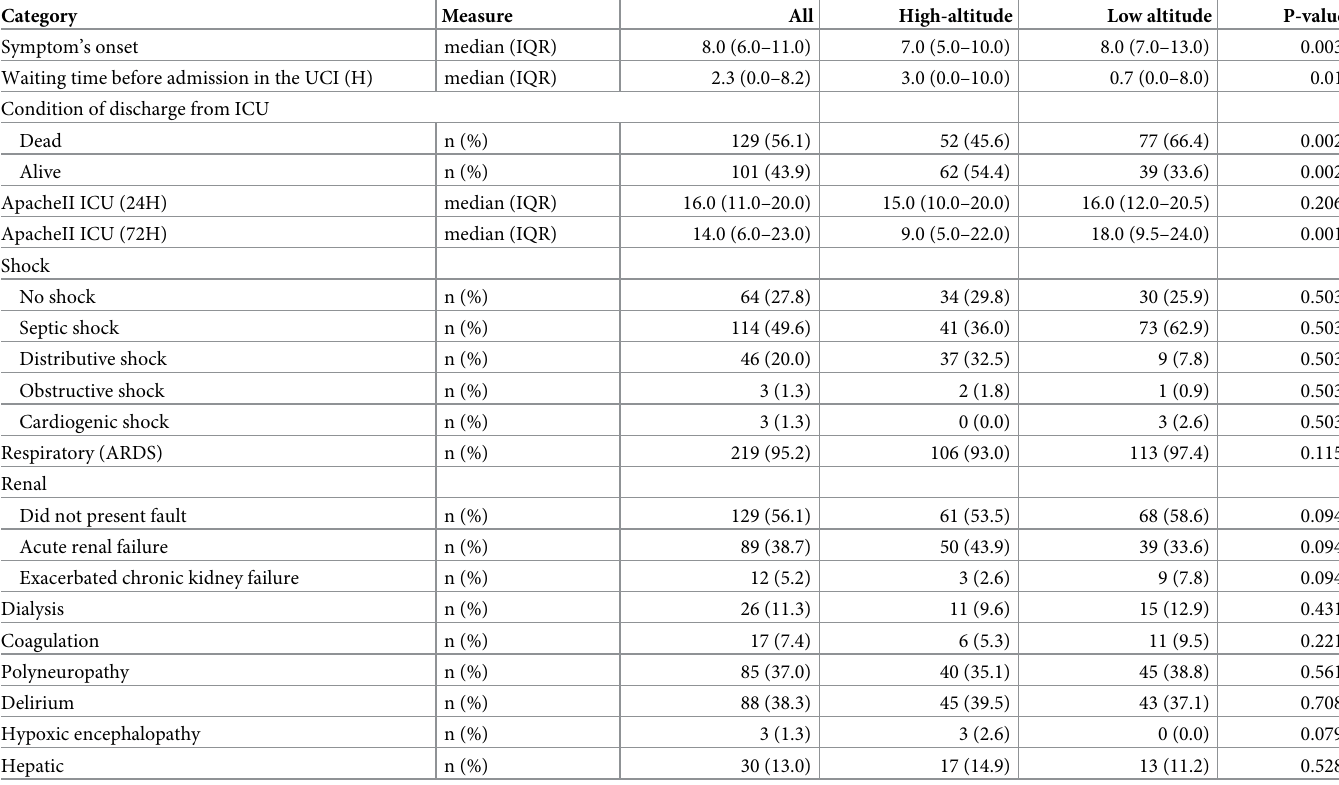
Table 2. Analysis of the chi-square, mean and median differences for clinical predictors for COVID-19 mortality among critically ill patients living at low and high-altitudes which were hospitalized in intensive care